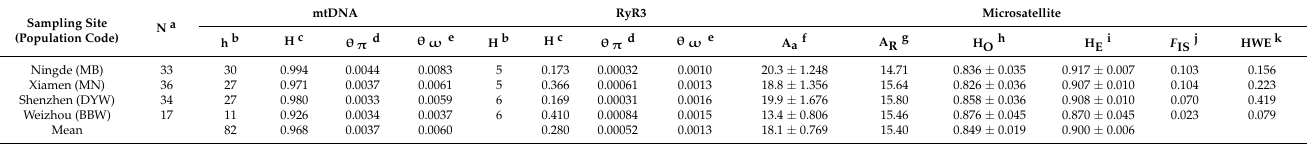
Table 1. Summary statistics for genetic variation of E. awoara from four different